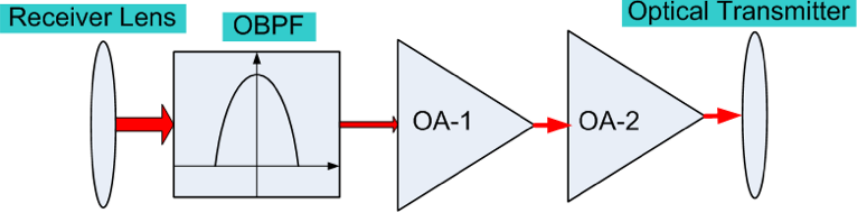
Figure 17. The OBPF implemented in a node-n to minimize signal with ASE, background noise, and noise modulation from an optical propagation transmitted by a previous node.